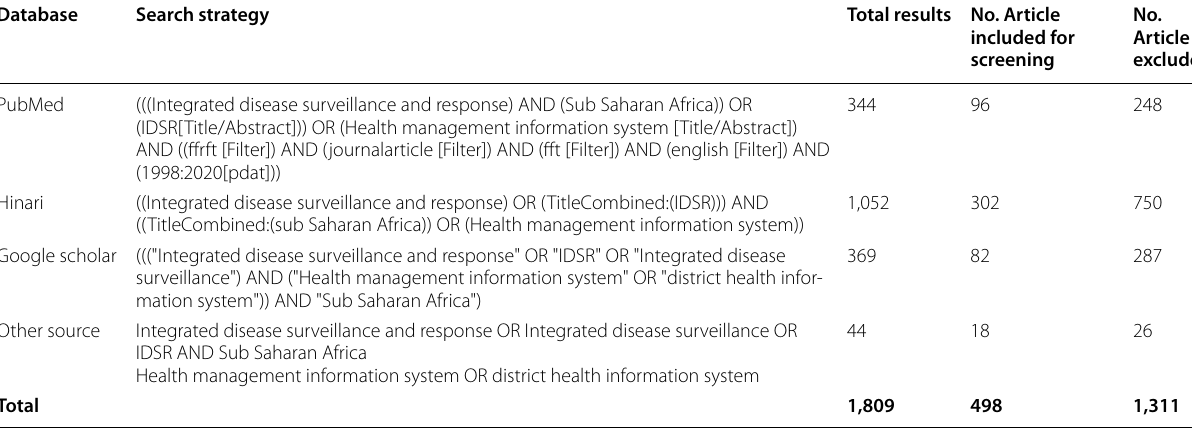
Table 1 Search strategy and the number of articles included for screening Database Search